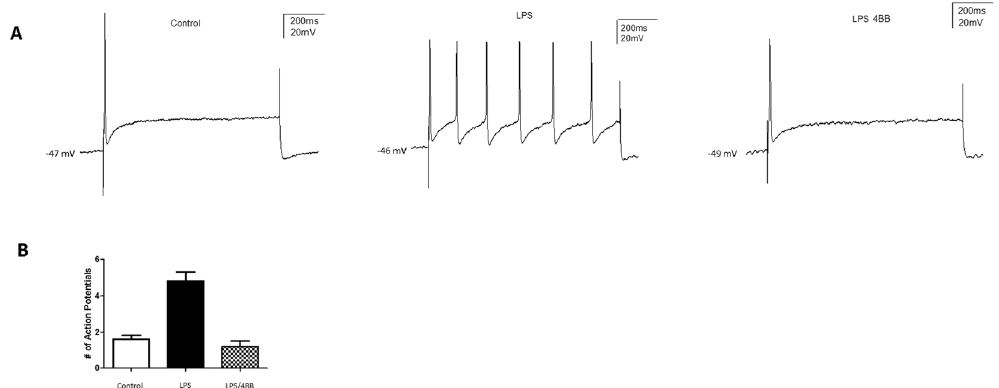
Figure 4. Lipopolysaccharide (LPS) increases in nociceptive neuron excitability is reversed by TAT-4BB. ( A ) Current clamp recordings were performed on small-to-medium ( > 30 μ m– > 40 μ m) diameter lumbar 4–5 dorsal root ganglia (DRG) neurons from naive rats. Firing of 1–2 action potentials was elicited by a 1 second depolarizing current injection (ranging from 0.1 to 2.0 nA depending on the cell) every 30 seconds. Representative recordings demonstrating that application of LPS and the subsequent increase in elicited action potentials in DRG sensory neurons can be reversed by administration of the 4BB MyD88 decoy peptide (n = 9 cells). ( B ) Group data showing that LPS caused a significant increase in DRG AP firing which is reversed by addition of TAT-4BB. Values are based on an n = 9 cells ∗ = p <